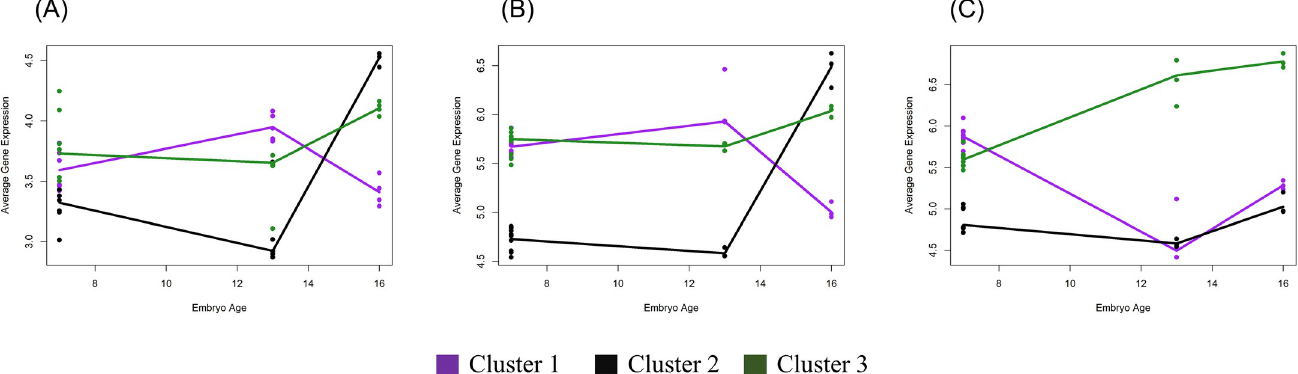
Fig 3. Trajectories of average expression for genes in the three clusters. Clusters were determined as illustrated in Fig 2. (A) Gene expression was obtained from an external and independent dataset from embryos obtained after artificial insemination, except for day-7 MOET embryos. (B) Gene expression in MOET embryos. (C). Gene expression in IVP embryos. MOET: embryos produced in vivo (ovarian superovulation followed by embryo collection and transfer). IVP: embryos produced in vitro. Cluster 1: purple lines. Cluster 2: black lines. Cluster 3: green lines.